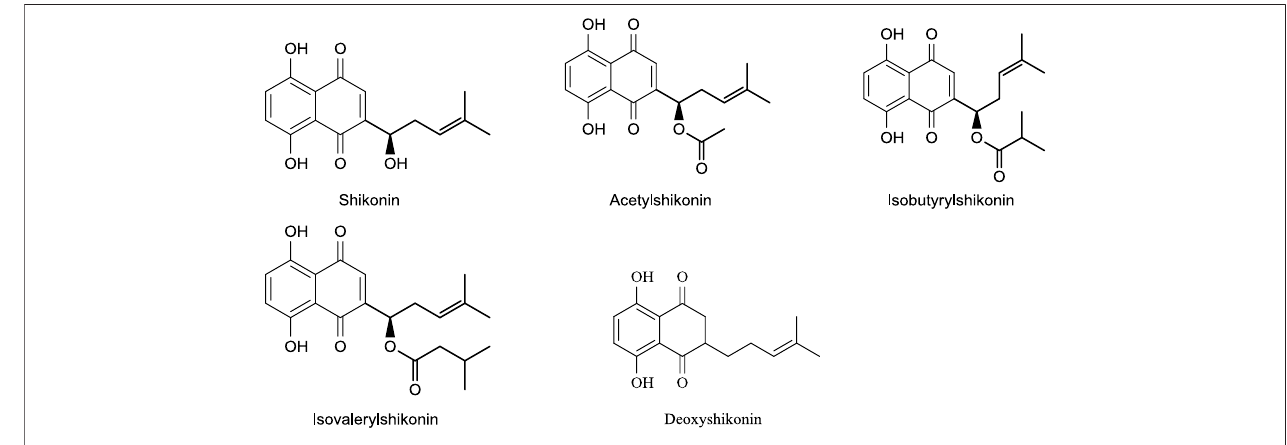
FIGURE 8 | Shikonin derivatives with potent anticancer activity (Rajasekar et al., 2012).